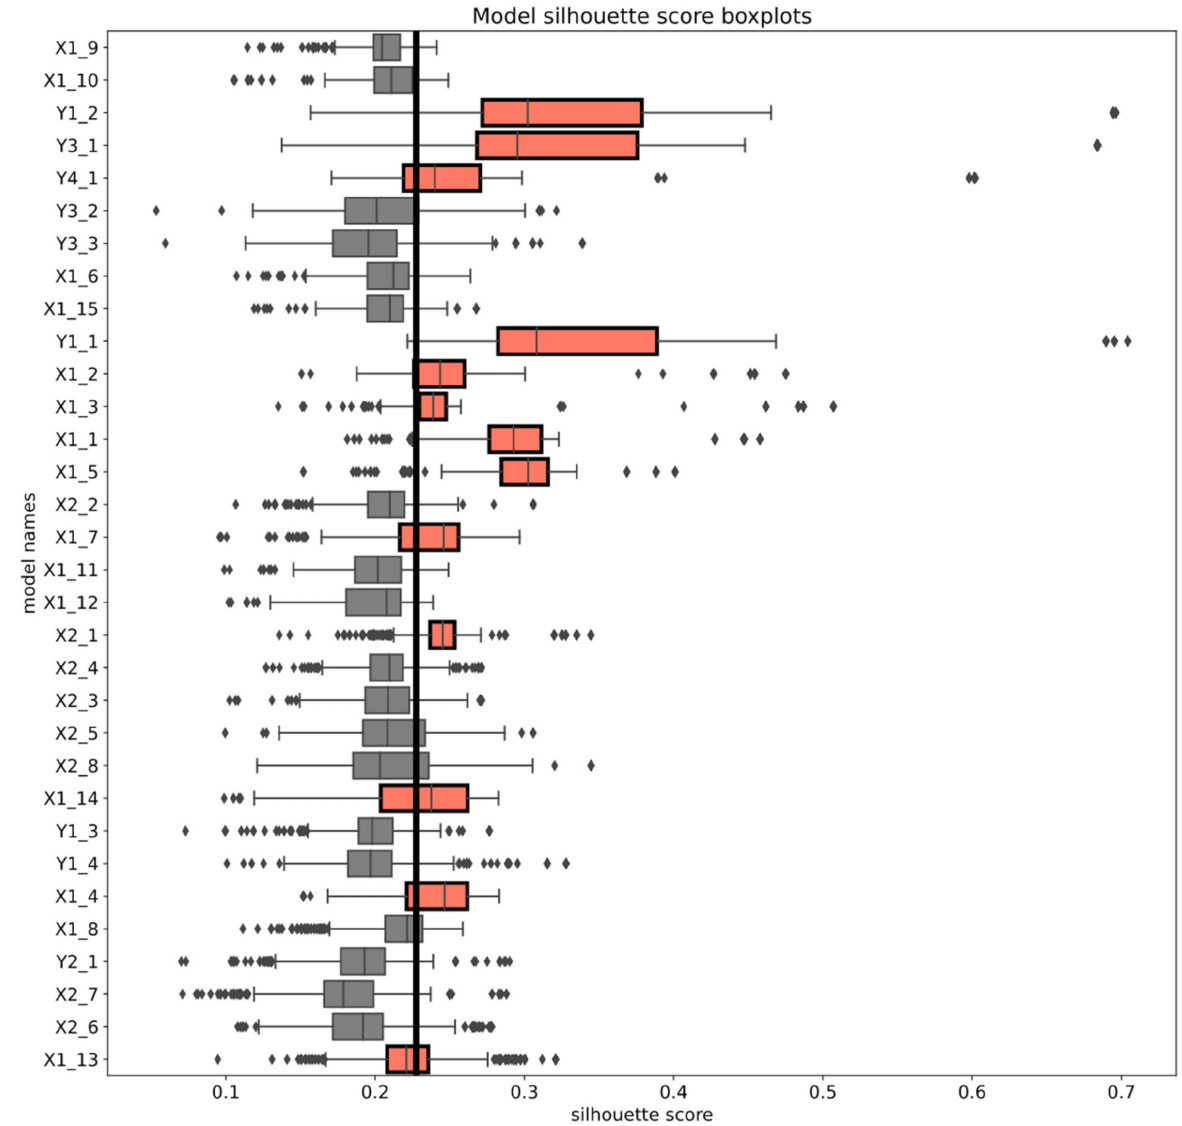
Figure 7. Different model silhouette score boxplots with the black line indicating average silhouette score. The red color represents models that were chosen for further